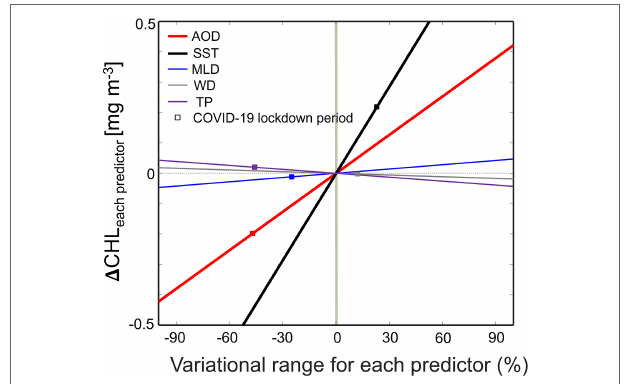
FIGURE 7 | Empirical variation coefficient of each predictor with the climatology of each variable from March 2003 to 2021. Red and black lines indicate the difference for CHL along variational AOD ( Δ CHL AOD ) and SST ( Δ CHL SST ), respectively. Blue, gray, and purple lines represent the Δ CHL MLD , Δ CHL Δ CHL WD , and TP , respectively. Square boxes defined CHL according to the conditions of each predictor in the COVID-19 lockdown period. The green line and gray dot show CHL’s zero and climatology condition for Δ CHL each predictor ,